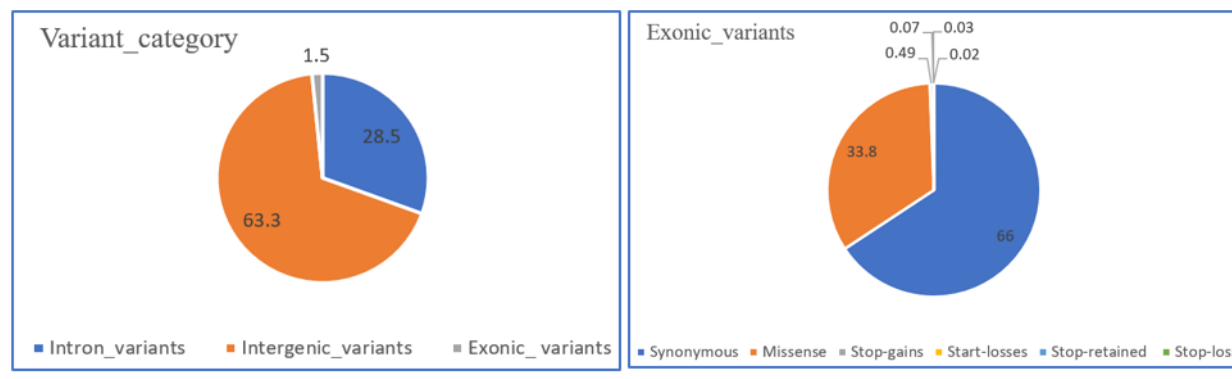
Figure 3. Dispersal of SNPs following annotation classifications (15 sheep populations).